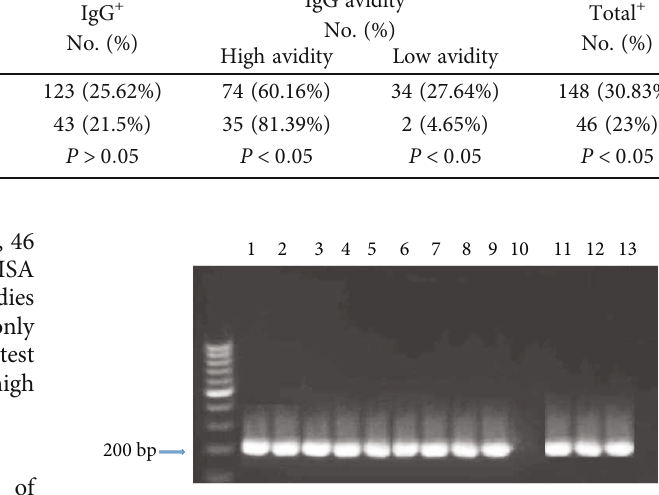
Figure 2: Ampli fi cation of a 194bp band of T. gondii DNA in the blood, placenta, and umbilical cord samples. Lane M: molecular weight marker; Lane 1: positive control; Lanes 2-9 and 11-13: positive samples; Lane 10: negative control (2% agarose gel electrophoresis).